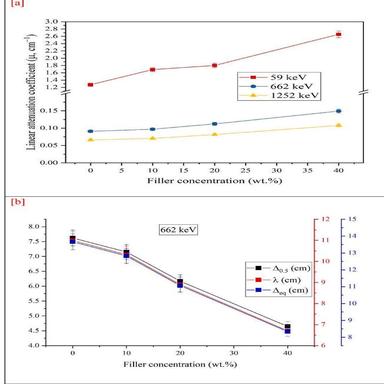
Influence of the filler concentration on linear attenuation coefficient (μ, cm− 1 ) and mean free path (λ, cm), half-value thickness (Δ0.5, cm), and the lead equivalent thickness (Δeq, cm) of the fabricated composites.